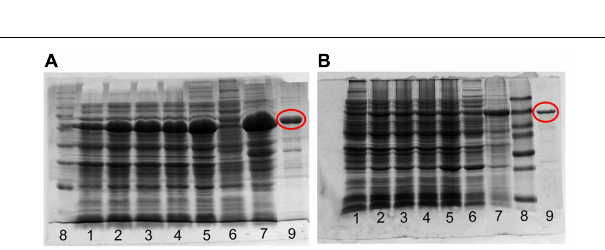
FIGURE 5 | Expression and purification of the recombinant SOHLH protein in oysters. (A) SOHLH1 and (B) SOHLH2. 1, uninduced; 2–5, induced 3, 4, 5, and 12 h, respectively; 6, supernatant; 7, inclusion body; 8, mark; 9, purification protein. The products of the purified protein are circled in